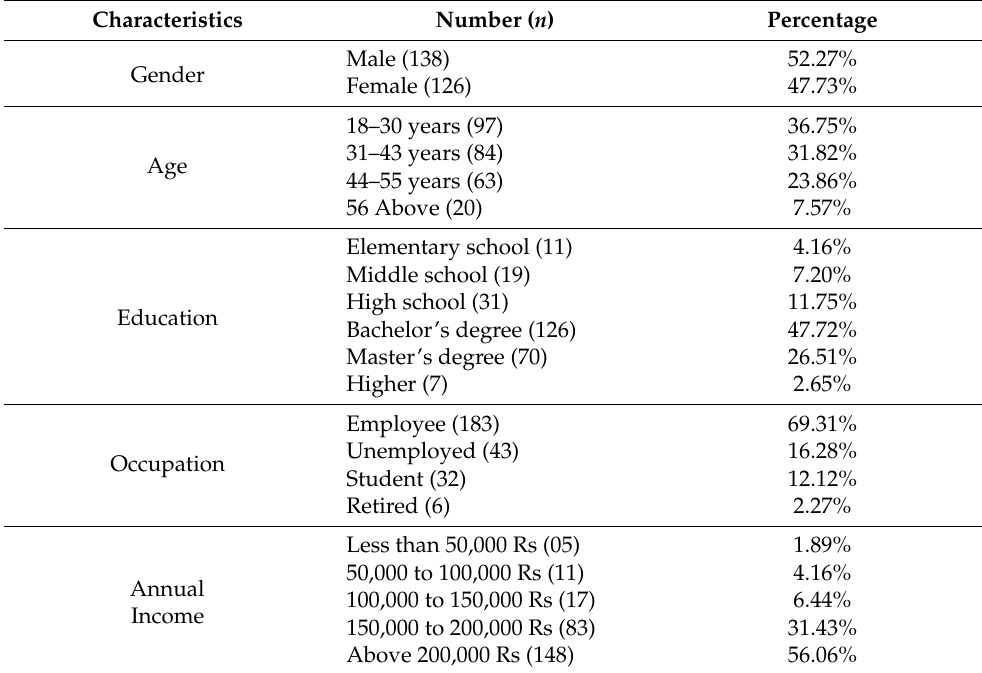
Table 2. Demographic Profile of